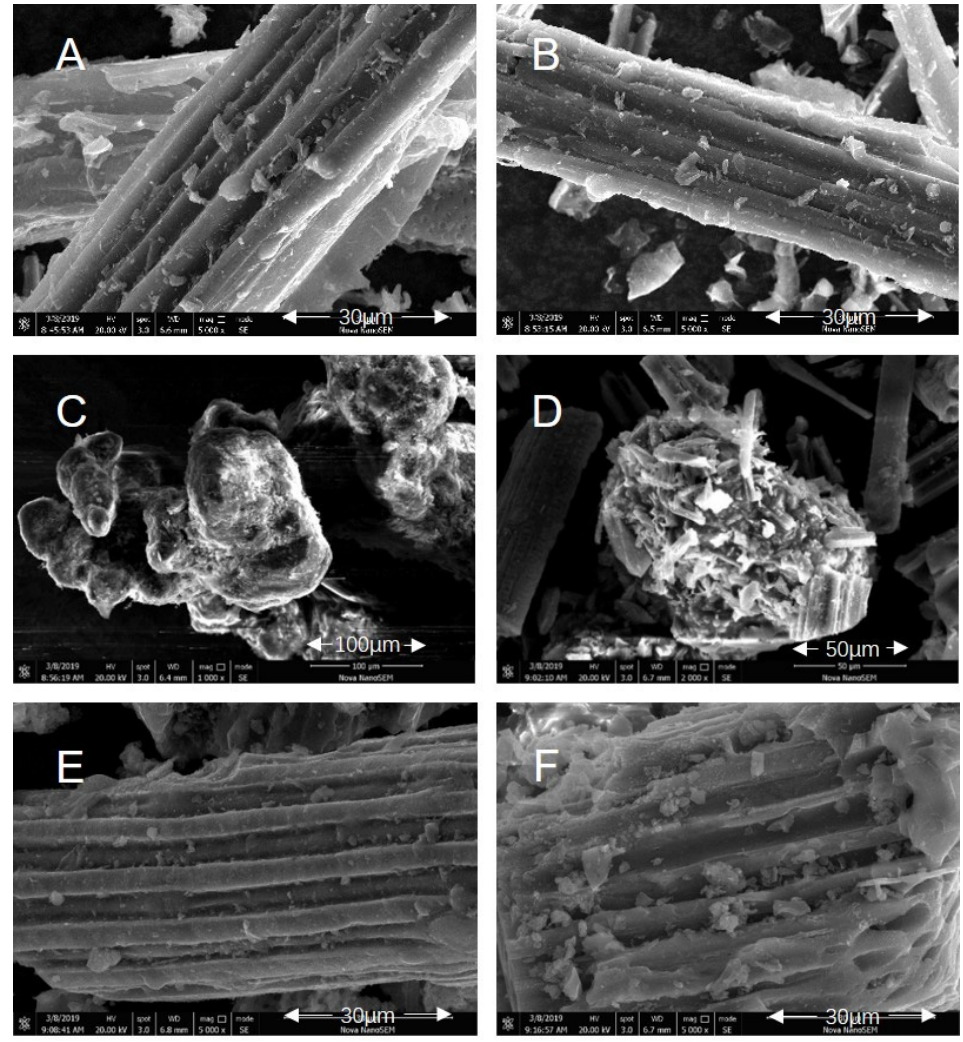
Figure 1. Scanning electron microscope images of ( A ) BC 800, ( B ) BC 700, ( C ) BP 5:5, ( D ) BP 6:4, ( E ) BPP 5:1:4, ( F ) BPP 4:1:5.